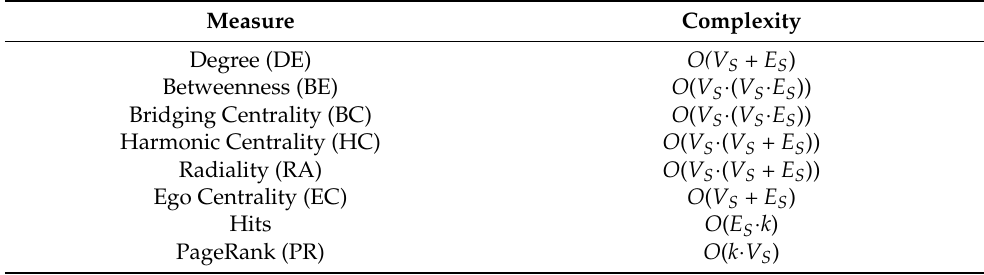
Table 1. The complexities of the examined importance measures. Measure